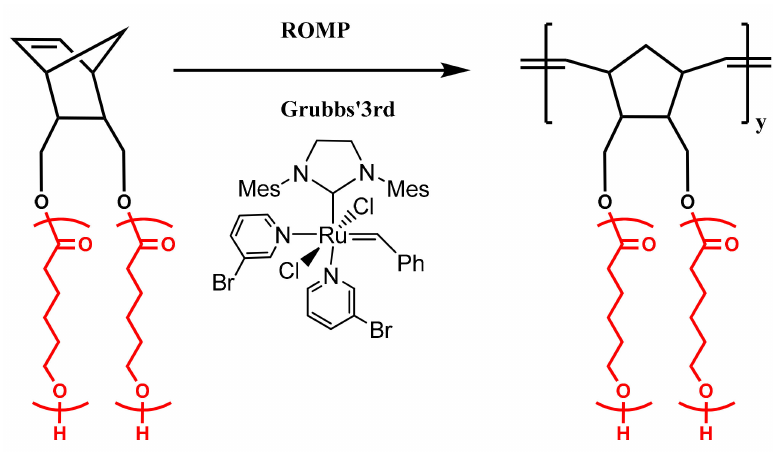
Figure 4. Synthesis of DB-PCL. Table 2. Molecular characteristics of the double homopolymer